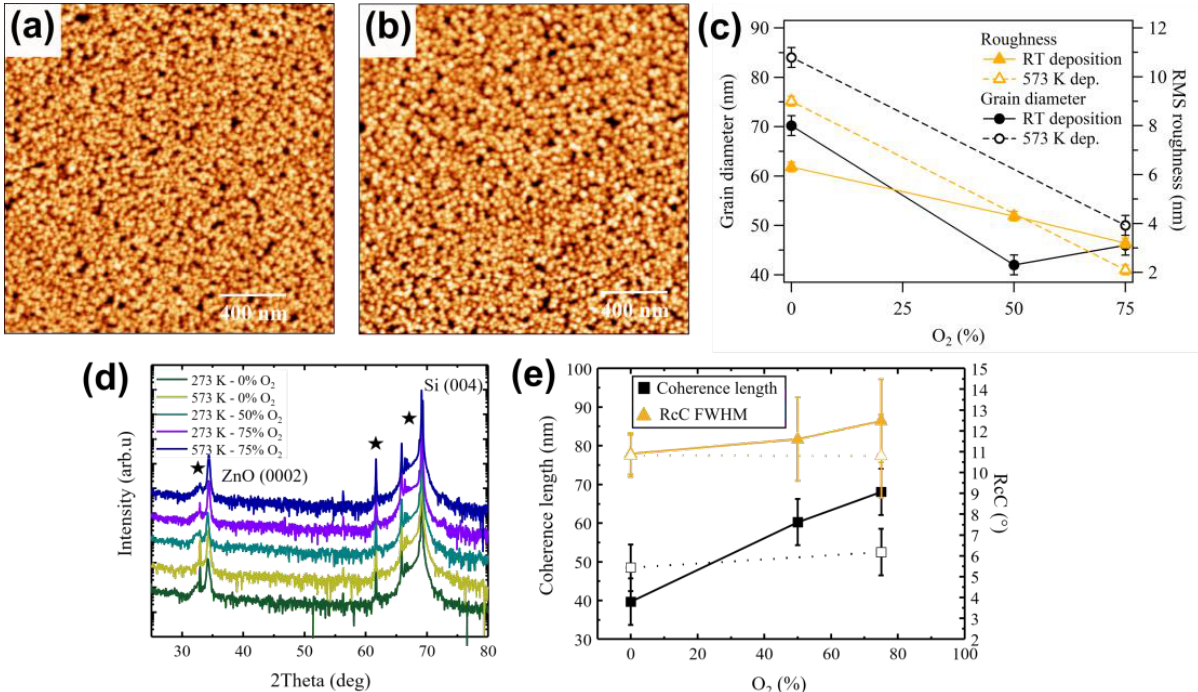
Figure 3. AFM images of size 2 × 2 µ m 2 of ZnO deposited with ( a ) 50% and ( b ) 75% O 2 at RT. ( c ) Average grain diameter (black dot) and RMS roughness (orange triangle) as obtained by grain analysis of AFM images of surface as a function of oxygen content during deposition. Empty markers are the corresponding curves obtained from films deposited at 573 K. ( d ) XRD plots, ( e ) coherence length (black squares) and rocking curve FWHM (orange triangles) for increasing oxygen content for RT (fill triangles and squares) and 573 K depositions (empty triangles and squares). The XRD signals are vertically shifted by a constant.